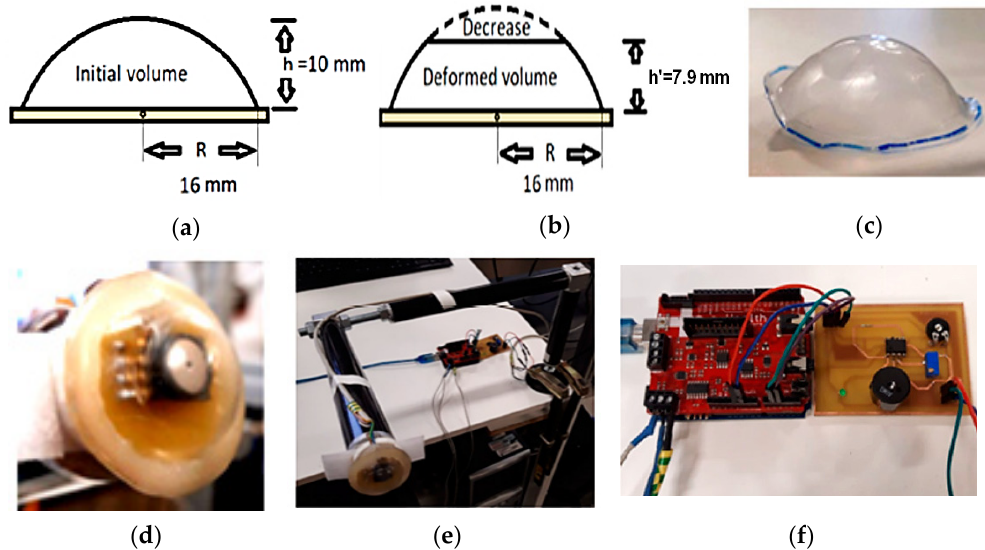
Figure 4. ( a ) Initial position without deformation; ( b ) deformed housing positioned on the artery; ( c ) dome housing; ( d ) housing glued on the PCB; ( e ) anchor system; ( f ) sound alarm system [32].